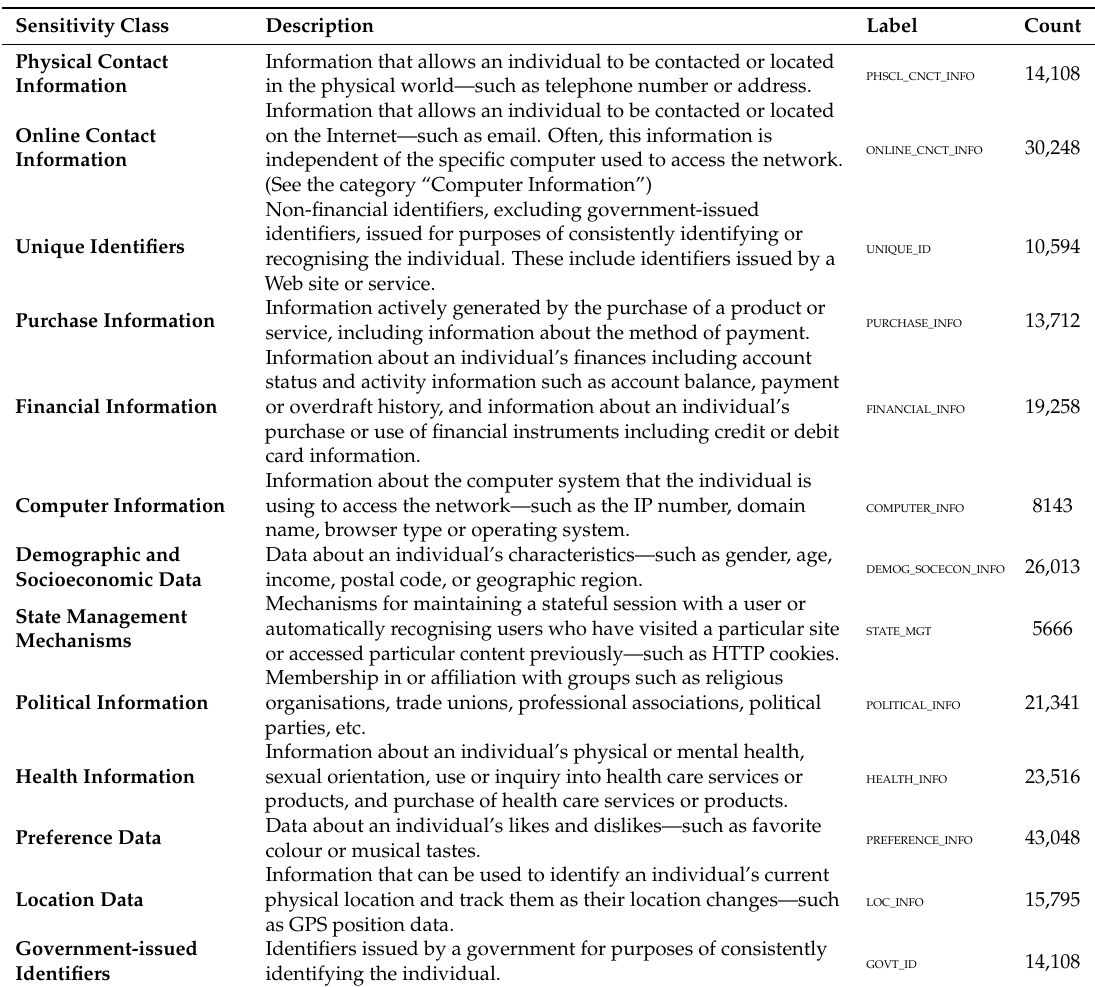
Table 1. Sensitivity classes used for multi-class classification. (Source: P3P Standard [4]) and the count of sensitive tokens in our dataset per